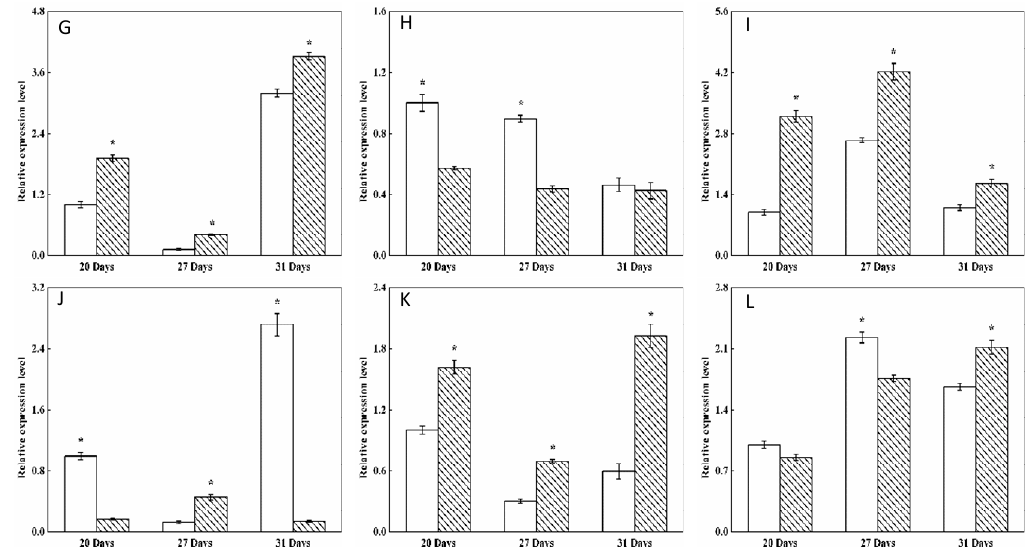
Figure 5. Transcription levels of the branching enzyme (BE), debranching enzyme (DBE), phosphorylase (PHO) and disproportionating enzyme (DPE) starch synthesis-related enzyme genes in wheat grains of BSMV-TaRSR1-infected and BSMV-GFP-infected spikes at 20, 27 and 31 days after anthesis. Transcription levels were measured by qPCR using Actin gene as internal control. ( A – L ), transcription levels of TaBEI , TaBEIIa , TaBEIIb , TaBEIII , TaISA1 , TaISA2 , TaISA3 , TaPUL , TaPHOL , TaPHOH , TaDPE1 and TaDPE2 genes, respectively. Each value is the mean ± standard deviation of three independent biological replicates. Asterisks indicate significant differences ( p < 0.05).